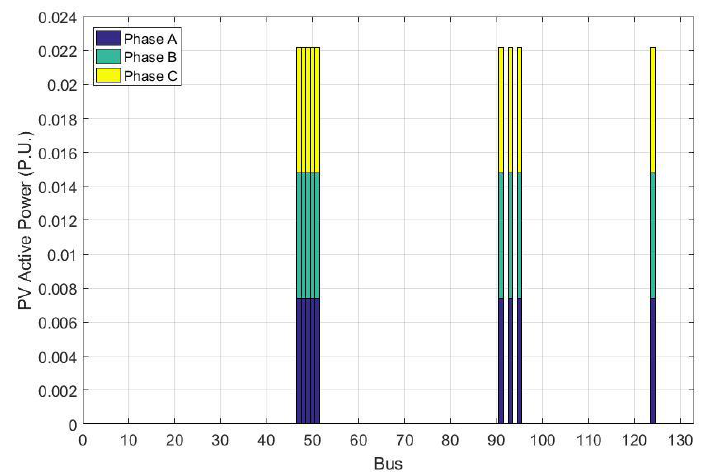
Figure 4. IEEE 123-Bus Maximum PV Active Power, 20% PV Penetration.